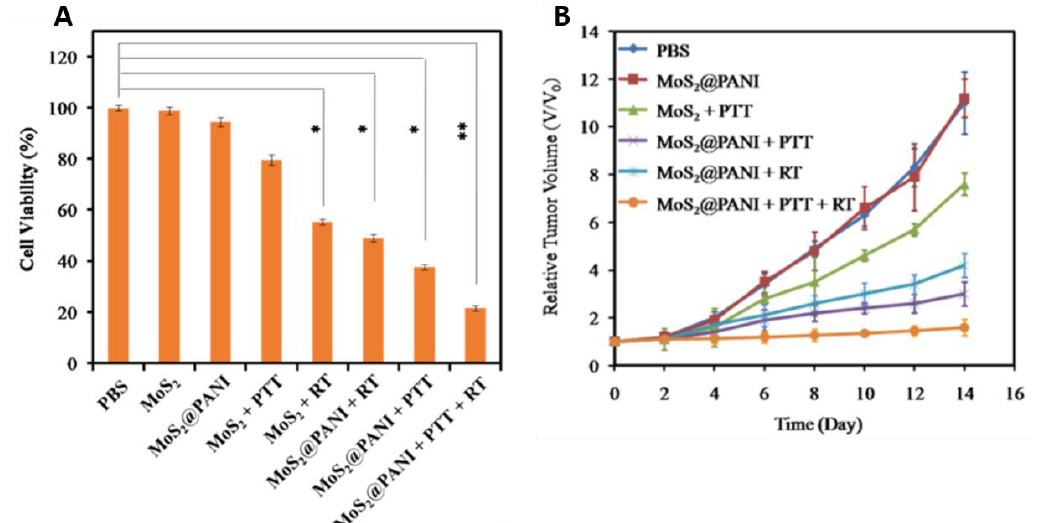
Figure 5. ( A ) Cell viabilities of 4T1 cells treated with PBS, MoS 2 , or MoS 2 @PANI with or without laser irradiation (808 nm, 1.5 W cm −2 ) and X-ray radiation (6 Gy). ( B ) Tumor growth in different groups of mice after various treatments (images are reproduced from [59] with the copyright permission from American Chemical Society).